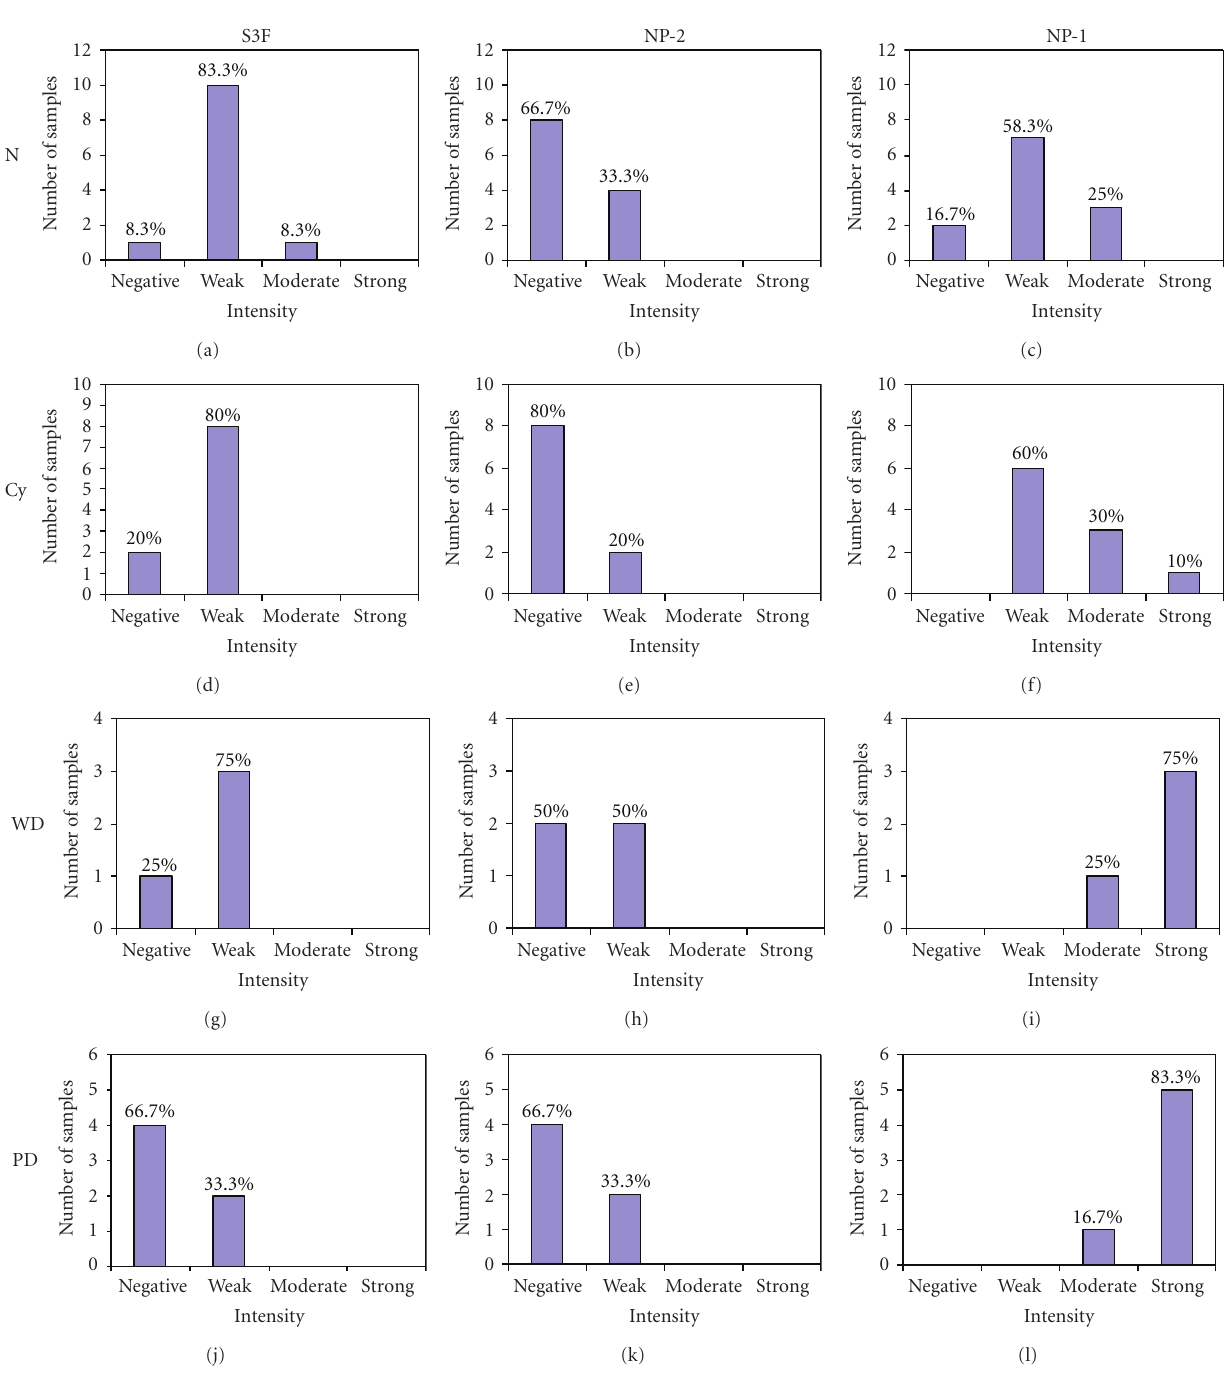
Figure 2: Graphical depiction of S3F, NP-2, and NP-1 expression with epithelial ovarian cancer progression. Immunohistochemically stained sections of normal (N), serous cystadenomas (Cy), well-di ff erentiated (WD) and poorly di ff erentiated (PD) serous adenocarcinomas were evaluated for expression of S3f, NP-2 and NP-1 and scored as negative, weak, moderate, or strong as described in Materials and